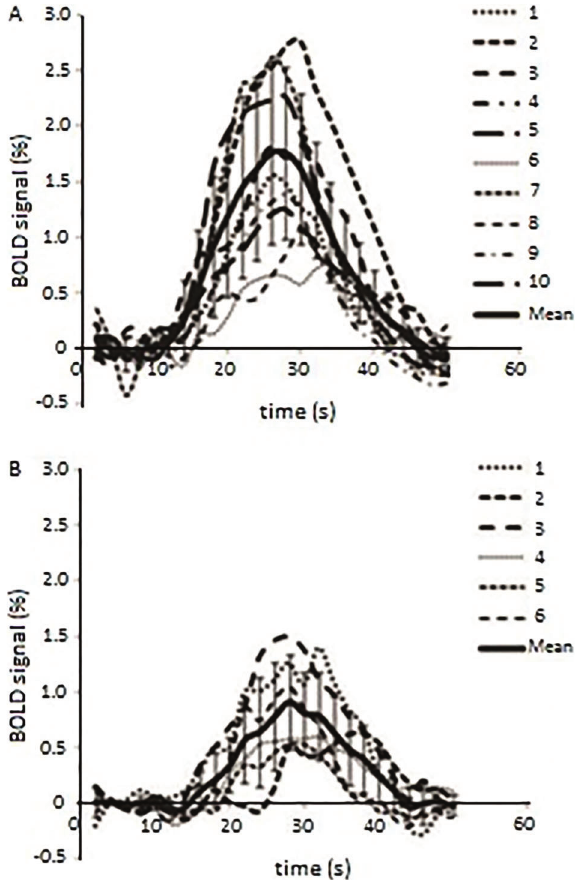
Figure 5. Blood oxygenation level-dependent (BOLD) contrast response to hypercapnia for ( A ) young and ( B ) elderly adults, showing a great inter-subject